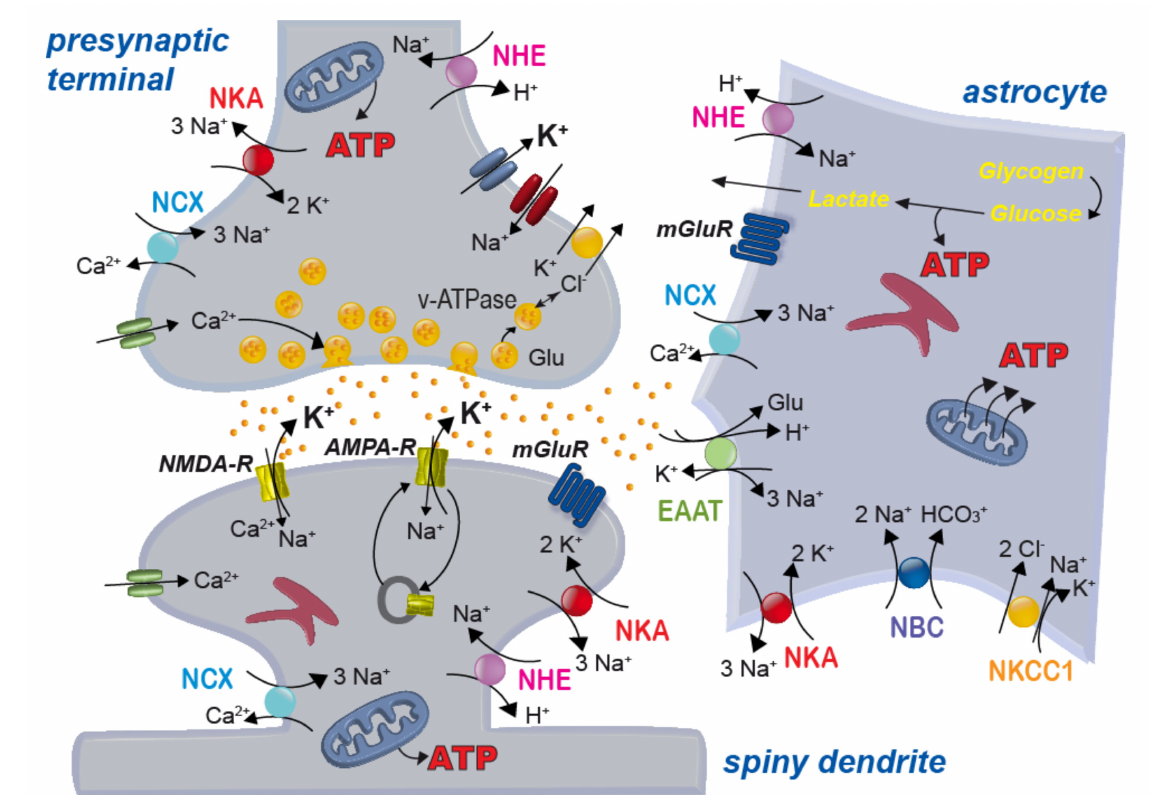
Figure 3. Scheme of a glutamatergic synapse and main ion transport mechanisms across the plasma membrane of neurons and astrocytes. NHE: sodium/proton exchanger; NKA: sodium/potassium-ATPase; NCX: sodium/calcium exchanger; NBC: sodium-bicarbonate-cotransporter; NKCC1: sodium-potassium-2 chloride cotransporter 1; EAAT: excitatory amino acid transporter; NMDA/AMPA-R: NMDA/AMPA-receptor; mGluR: metabotropic glutamate receptor; v-ATPase, vesicular ATPase; Glu: